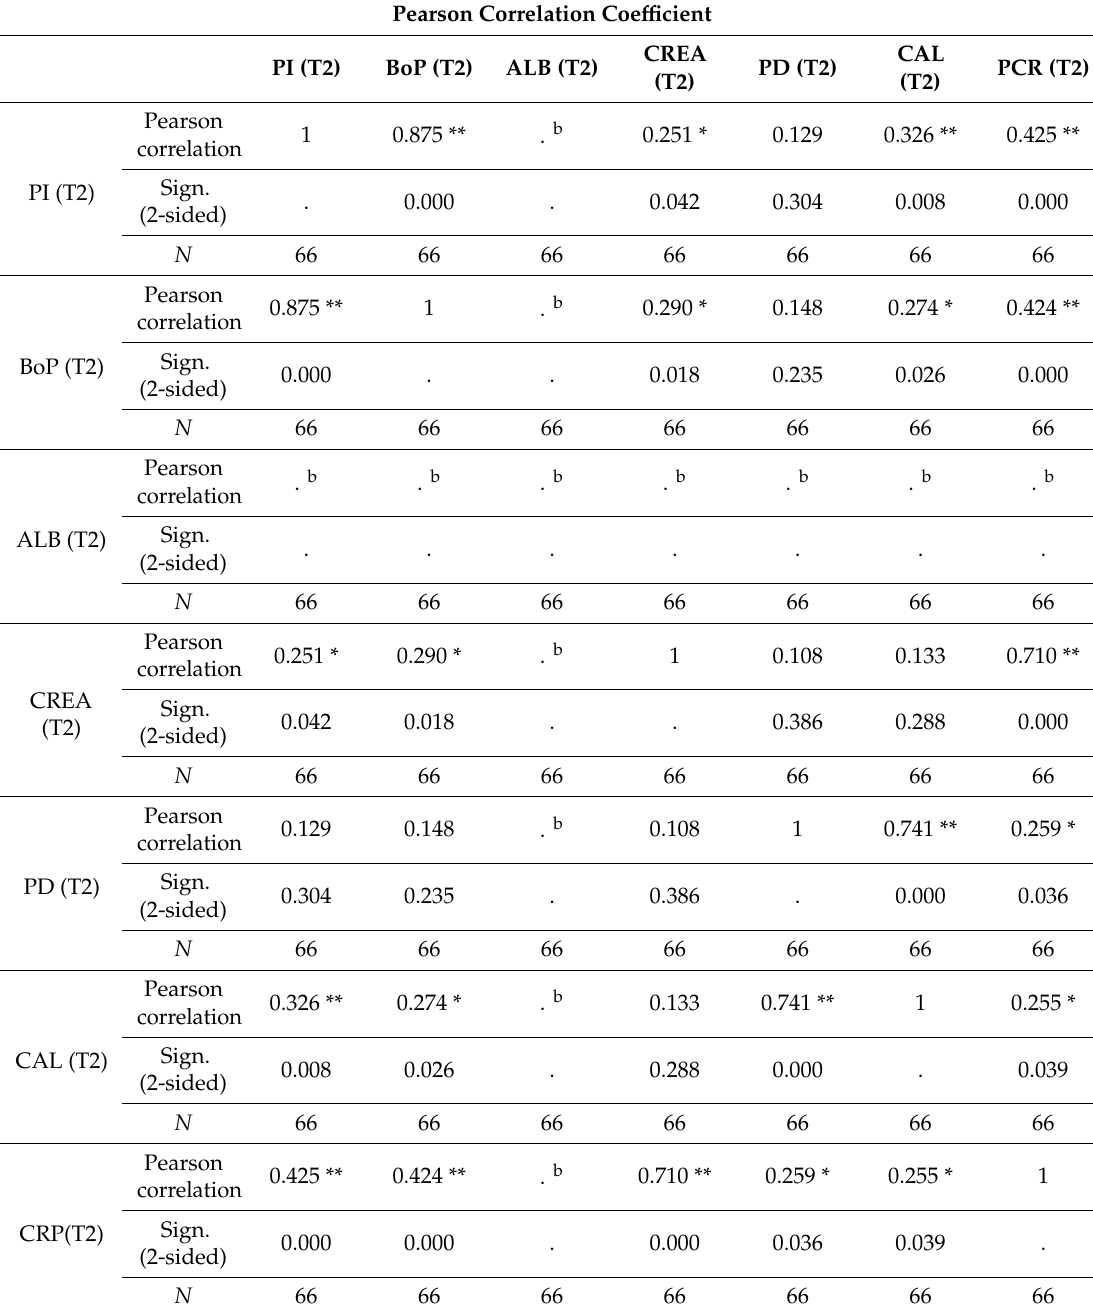
Table 5. Pearson’s correlation coe ffi cient of variables at